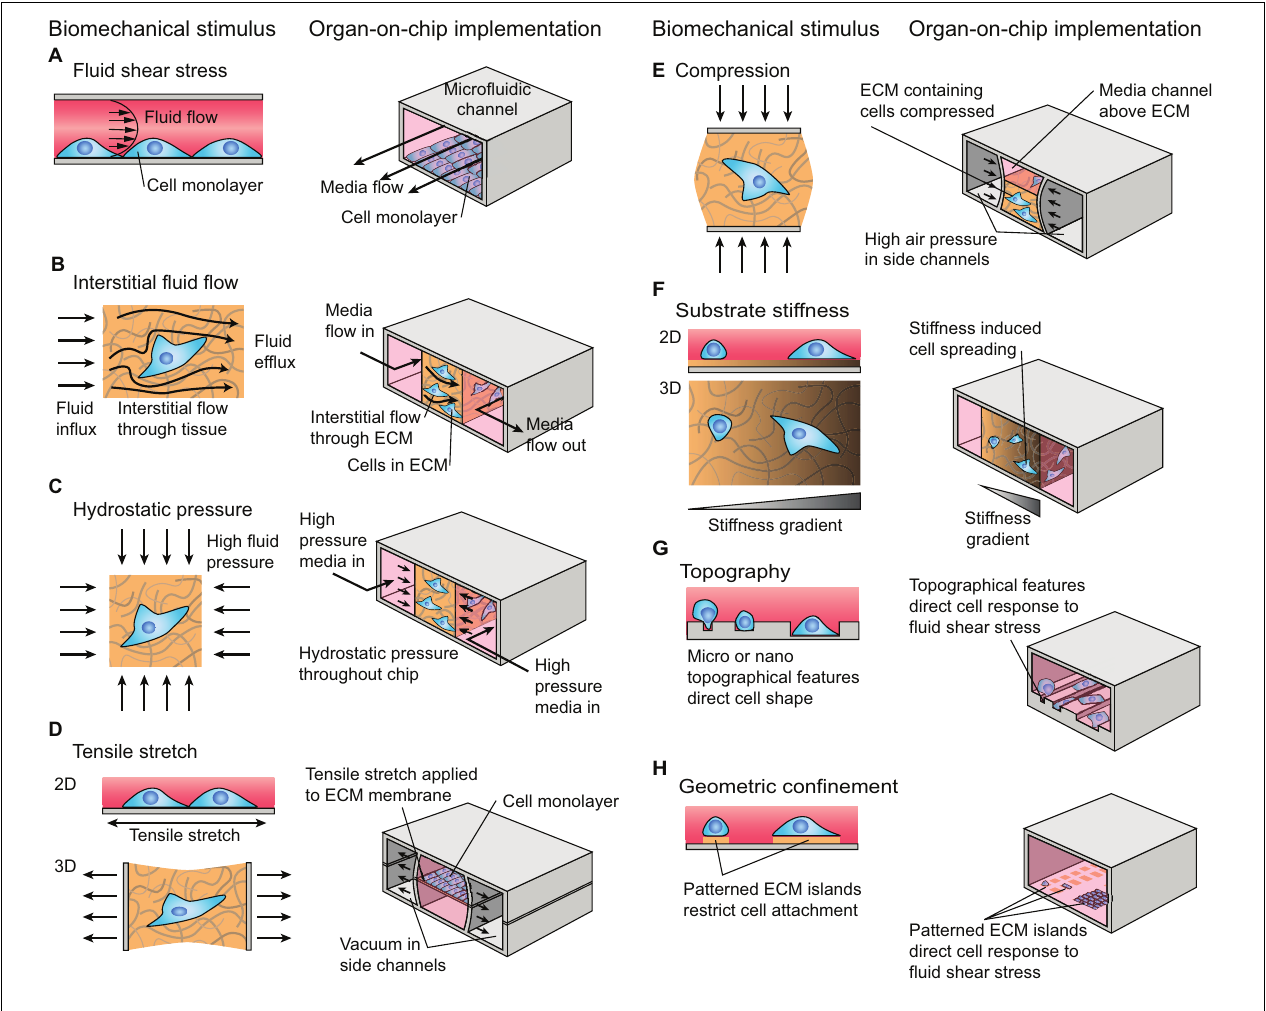
FIGURE 1 | Schematic illustration of biomechanical stimuli and examples of how these stimuli could be implemented in organ-on-chip systems. (A–E) Active biomechanical stimuli including (A) fluid shear stress, (B) interstitial fluid flow, (C) hydrostatic pressure, (D) tensile stretch, and (E) compression. (F–H) Passive biomechanical stimuli including (F) substrate stiffness, (G) substrate topography, and (H) geometric